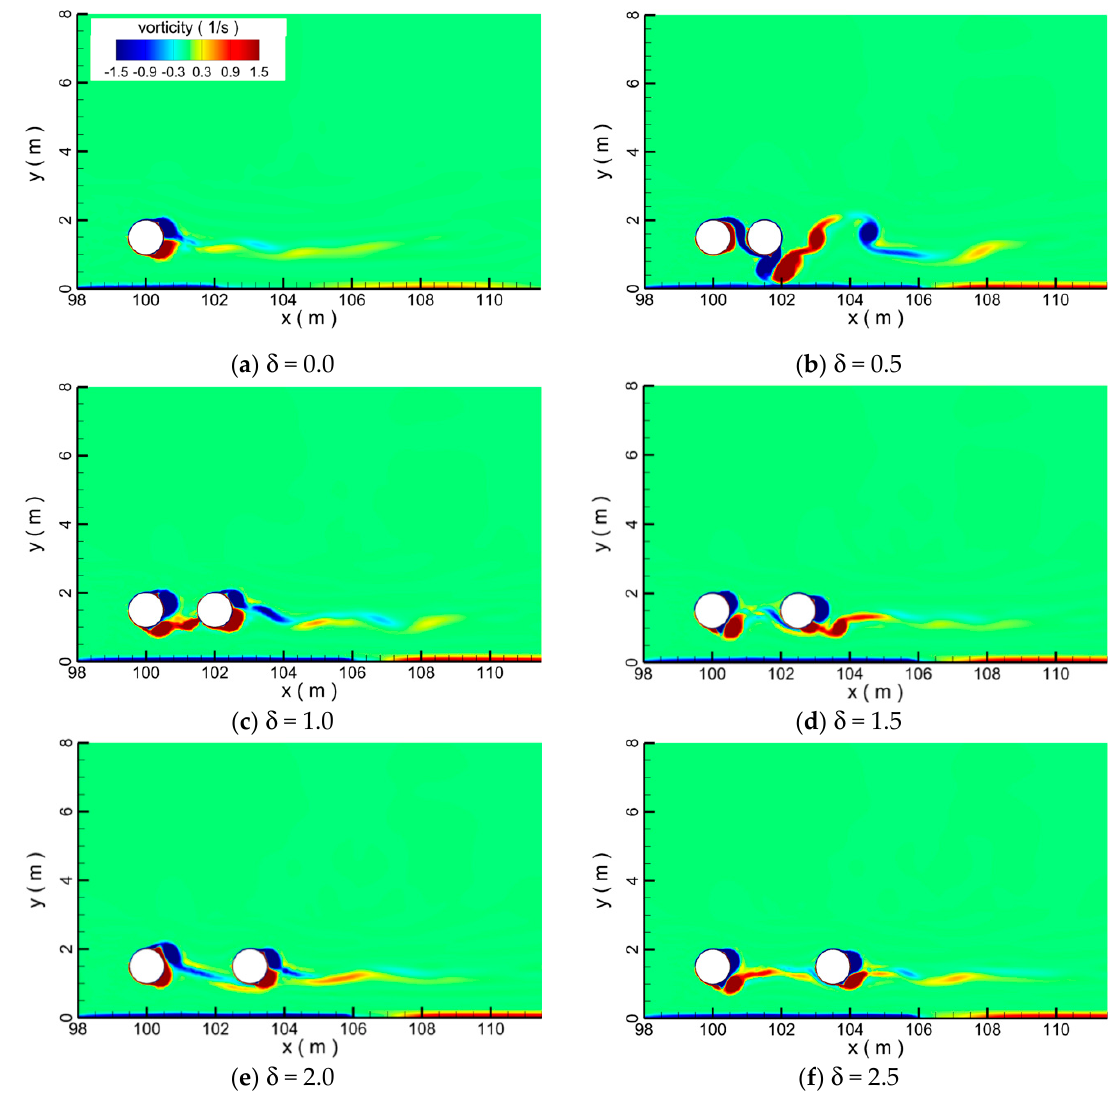
Figure 29. Same as Figure 28 but for a solitary wave at t = 22 s.